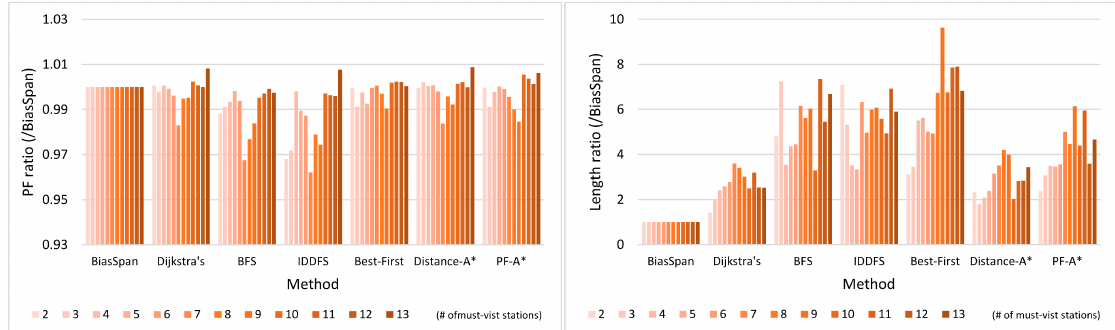
Figure 6. PF ratio ( left ) and length ratio ( right ) for methods under area range in Tainan dataset.